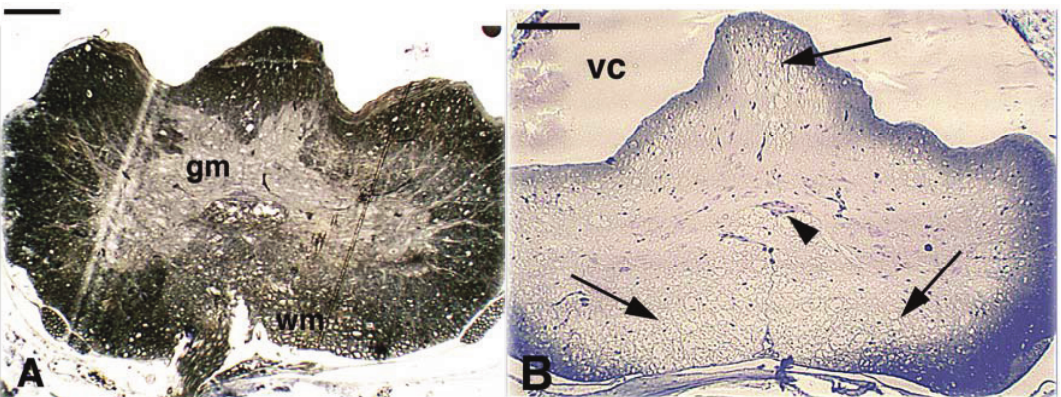
Figure 5. Representative proximal-distal cross-sections of lesion spinal cord at 29 days post-injury. A , proximal spinal cord showing the characteristics H-shapes of the grey matter surrounded by numerous myelinated axons in the white matter. Scale bar, 0.1 mm. B , a more caudal section closer to the transected region but still in the proximal SC stump shows numerous vacuolated axons (arrows) in the white matter. The arrowhead indicates the ependyma. Scale bar, 0.1 mm. C , a further caudal section shows the presence of large vacuolated areas (arrows) previously occupied by axons. The arrowhead indicates the ependyma. Scale bar, 0.1 mm. D , section of the reduced SC in the bridge region with the enlarged ependymal canal (arrowhead) while the distinction between grey (very reduced) and white matter appears irregular. Numerous degenerated axons are seen (arrows) and the SC is occupied by numerous glial cells. Scale bar, 0.1 mm. E , detail of the stratified ependymal canal with indicated pale cells (arrows) among ependymal cells. Another cells with basophilic cytoplasm is seen nearby the ependyma (arrowhead). Scale bar, 15 (cid:2) m. F , section across the bridge region between the two SC stumps formed by a scarring glial tissue (arrow), sparse nerve bundles and degenerating axons (arrowheads). Scale bar, 0.1 mm. G , more caudal part of the bridge showing the presence of bundles of nerves (arrows) within the surrounding dense connective (scar). Scale bar, 0.1 mm. H , distal spinal cord with the typical H-shaped grey matter surrounded by numerous degenerated axons in the white matter (arrows). The ependymal camnal (arrowhead) appear reduced as in the proximal stump. Scale bar, 0.1 mm. Legends: bv, blood vessel; e, ependyma; gm, grey matter; mx, meninx; n, neuron; na, neural arch; rc, regenerated cartilage; sc, spinal cord; sco, scarring connective-meninx; sn, small neuron; v, vertebra; vc, vertebral canal; wm, white